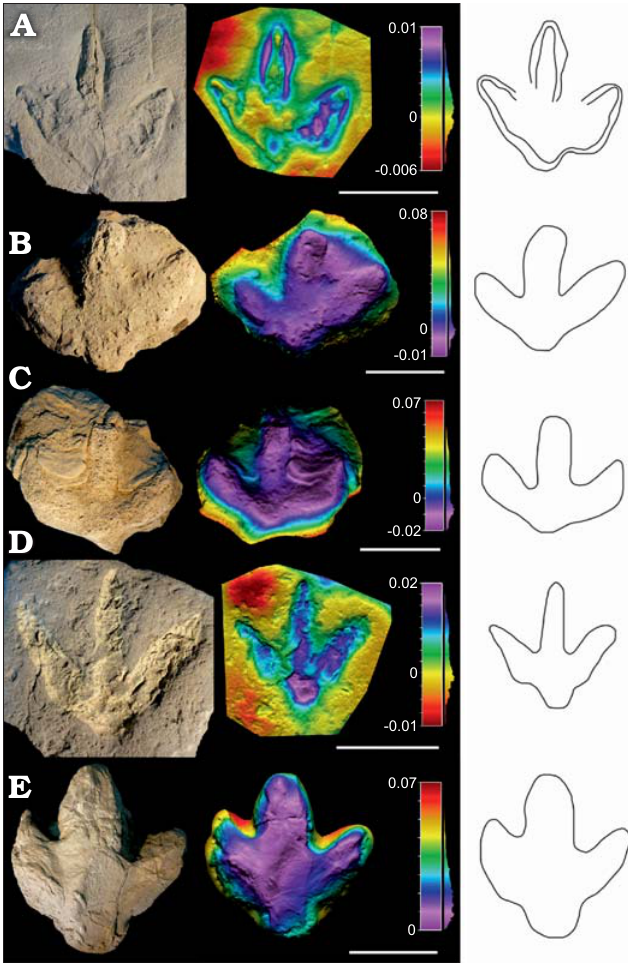
Fig. 2. Photographs, false-colour depth maps, and outline drawing of the tracks of high morphological quality (MP = 2) that belong to the Iguano- dontipodidae indet. morphotype. Portugal, Praia de Amoreira-Porto Novo Formation, upper Kimmeridgian (A, B) and Sobral Formation, upper Kim- meridgian–lower Tithonian (C–E). A . SHN.(JJS).ICNO.03, Valmitão Norte. Note that the track still preserves part of the infill. B . SHN.(JJS).ICNO.54, Valmitão Sul. C . SHN.(JJS).ICNO.48, Praia Azul. D . SHN.(JJS).ICNO.75, Foz Do Rio Sizandro. Note that the track has been painted and the real mor- phology is not exactly the same as the drawing. E . SHN.(JJS).ICNO.110, Foz Do Rio Sizandro. Scale bars E, 15 cm; A–C, 20 cm; D, 25